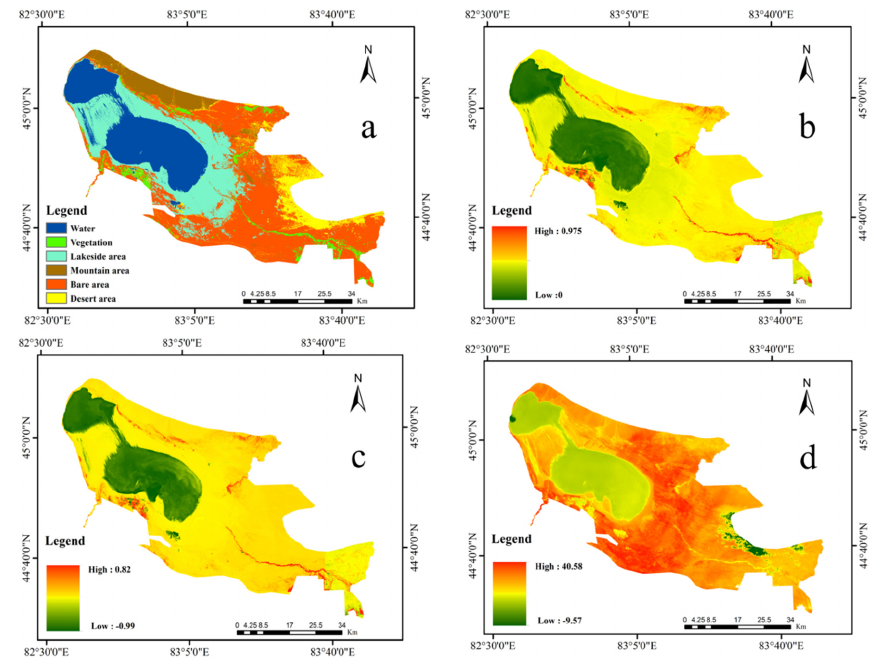
Figure 7. Data of salinization risk factors obtained by remote sensing in dry season: ( a ) spatial distribution of the LUCC risk factors; ( b ) spatial distribution of the NDVI risk factors; ( c ) spatial distribution of the PSRI risk factors; and ( d ) spatial distribution of the S_tem risk factors. The abnormal area is due to the distribution of a few cloud areas in the spatial distribution of the dry season temperature in the Landsat-8 image (August 2018). NDVI, normalized difference vegetation index; S_tem, land surface temperature; PSRI, plant senescence reflectance index; LUCC, land- use/land-cover.